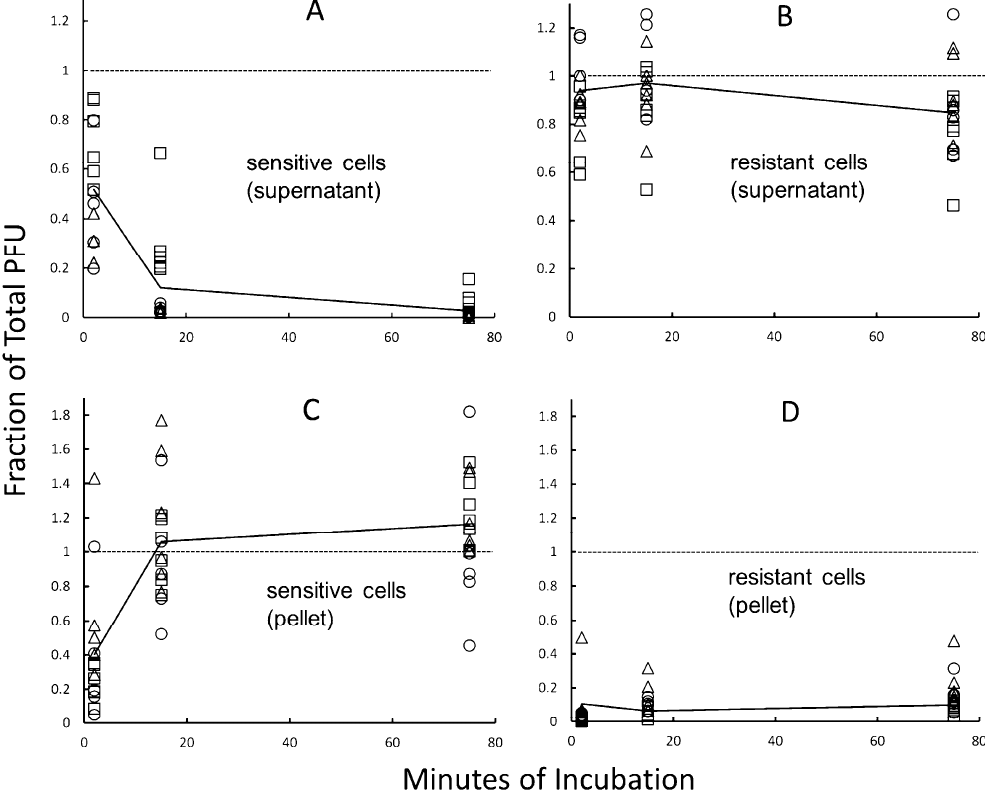
Figure 7. Virion binding. V3 (circles), V60 (squares) or V65 (triangles) were added at low MOI to either of two resistant clones of S. islandicus K00 16-4 (panel ( A , C )) or two sensitive revertants of spontaneously resistant clones (panel ( B , D )), and the resulting mixtures were as described in Section 2. Each data point depicts an independent, individual plaque count normalized to the number of PFU added to the cell suspensions (indicated by the dotted horizontal line); samples of unfraction- ated cell/virus mixtures yielded an average of 420 plaques under these conditions. Independent as- says were performed in triplicate for each combination of host and virus strain, and the average values for all combinations are connected by a solid line. Pellet fractions are corrected for the aver- age number of PFU in parallel sham (no-cell) controls, which was 1 plaque. 4. Discussion Although lytic archaeal viruses represent relatively few described species of the di- verse viruses of hyperthermophilic archaea, examples have been isolated from multiple geothermal regions worldwide [8,13,15]. Our results and those of others further indicate that lytic viruses resembling SIRVs form localized populations that can remain associated with specific hydrothermal features for periods of several years. This is illustrated by the SRC site, where a hydrothermal feature maintained high concentrations of SIRV-like vi- ruses over a six-year period, and an area within the Norris Geyser Basin, from which two